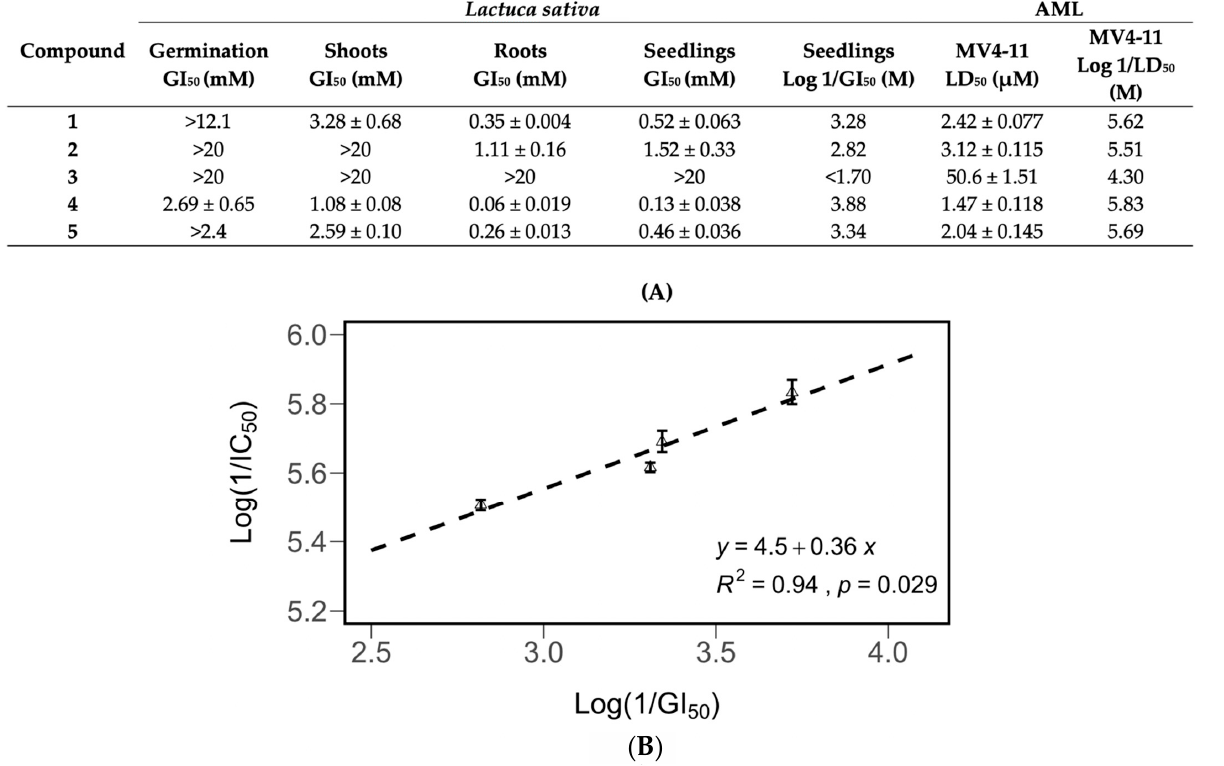
Figure 7. Inhibitory potency of compounds 1–5 against the growth and germination of Lactuca sativa seedlings, and their cytotoxic potency (Log 1/LD 50 ) against MV4-11 leukemia cells (B) . Correlation between the cytotoxic potency and the inhibitory potency (A) . All data are presented as the mean ±SEM. Compound 3 was not included in the derivation of the equation.